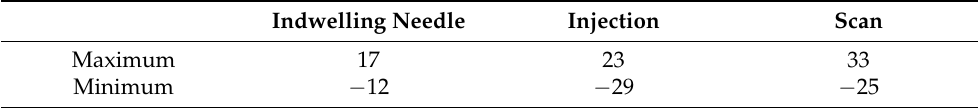
Table 4. Maximum and minimum time difference between the two groups (unit: